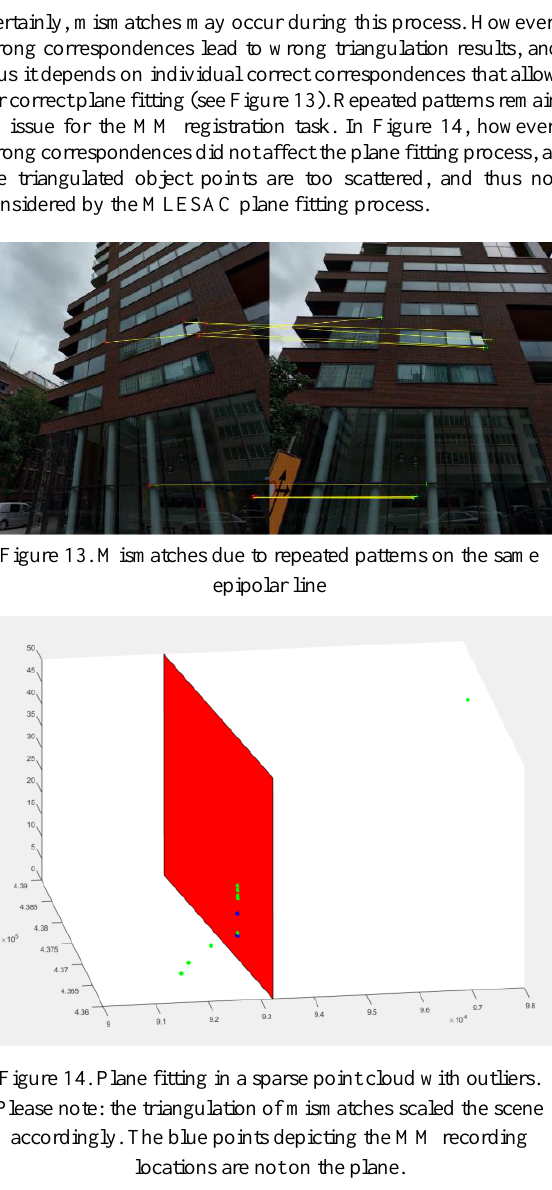
Figure 12. No planar objects in the scene prevent a continuation of the workflow